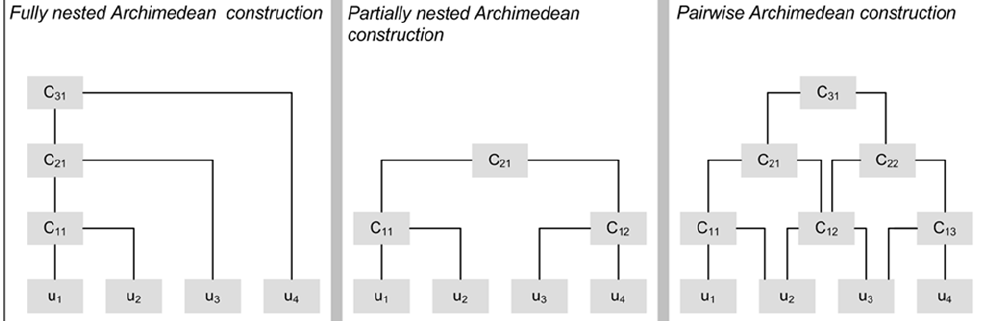
Fig. 4. Selected models to construct higher-dimensional